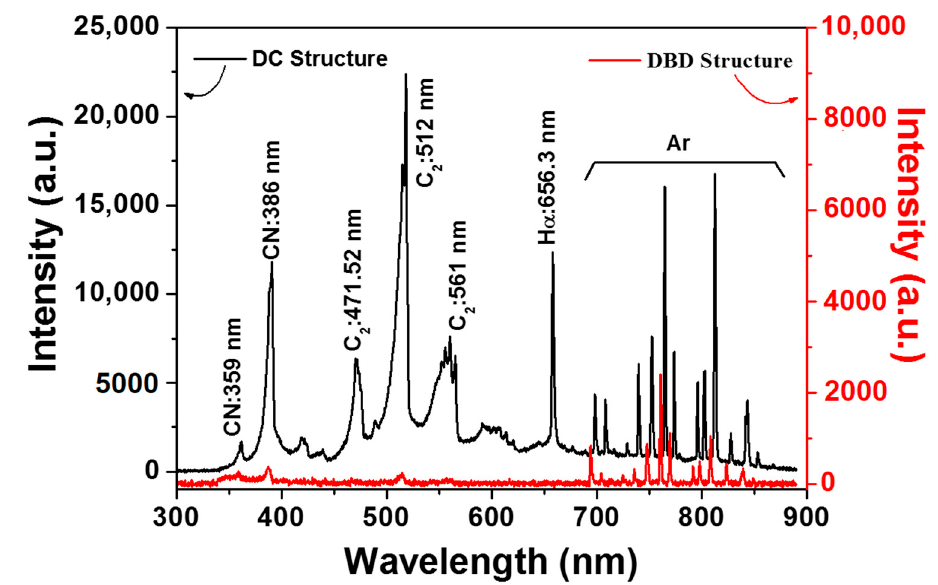
Figure 4. Optical emission spectra (OES) measured during plasma polymerization in the DBD structure compared to the previous DC structure.